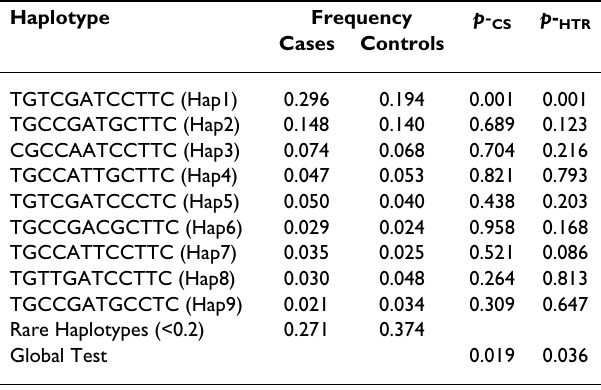
Table 5: APOE haplotype frequencies inferred by PHASE and Table 3: Distribution of genotypes and allele frequencies at the HTR and the corresponding p-values showing the levels of APOE gene in the Caucasian cases and controls difference between cases and controls. Locus Genotype Freq(q) Cases vs. Controls ( p